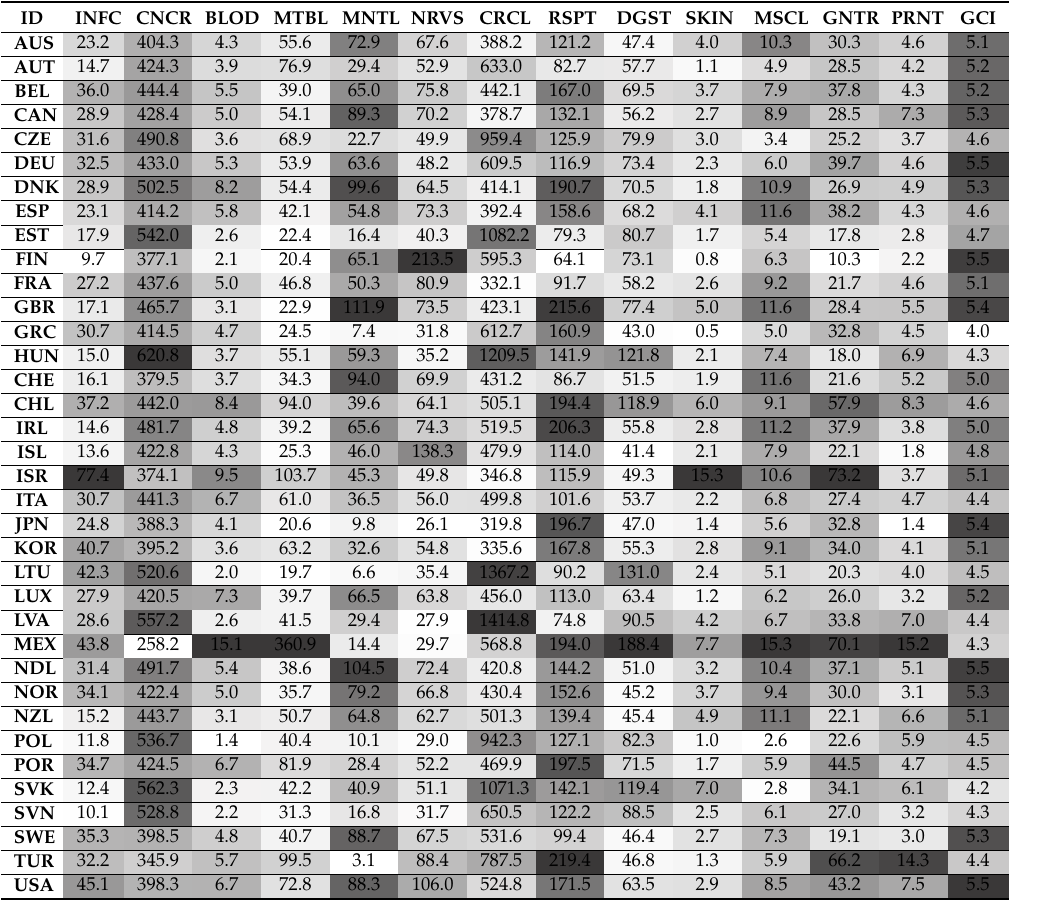
Table A1. Mean of Selected Variable by